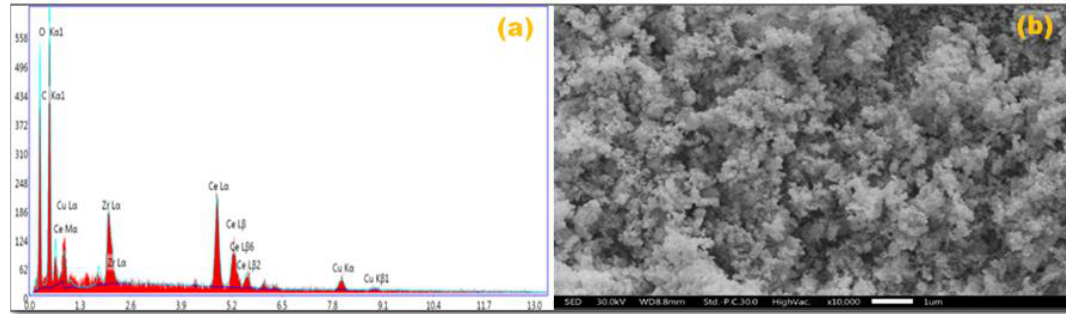
different concentration of Cu